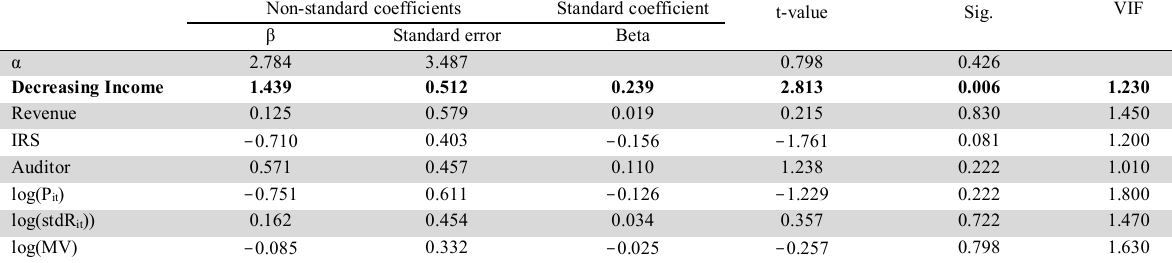
The results of testing the effect of adjustment after